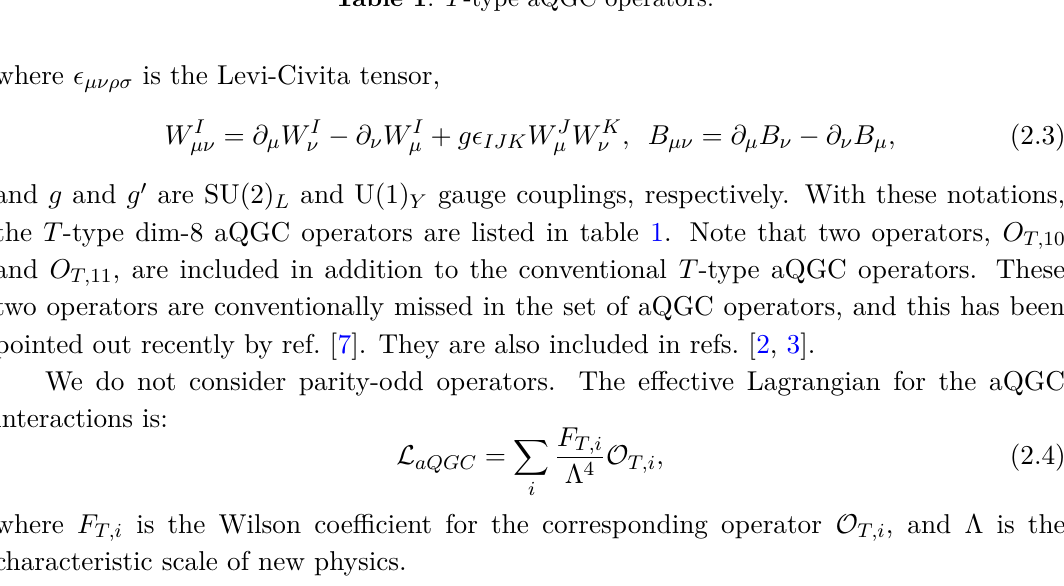
Table 1 . T -type aQGC